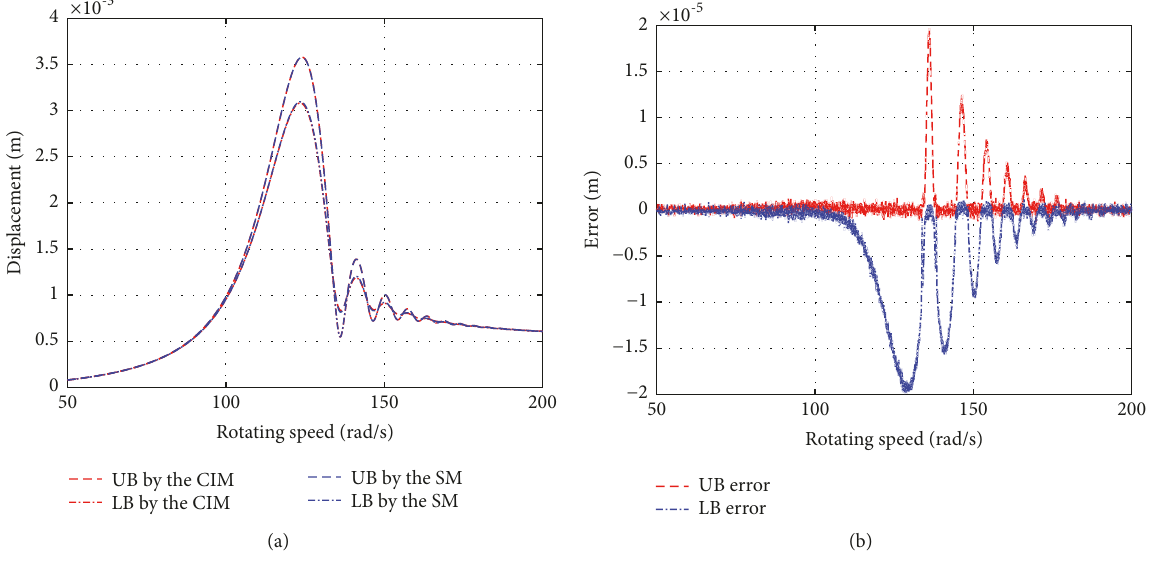
Figure 3: (a) Transient response of the rotor with uncertain mass unbalance and (b) calculation error.